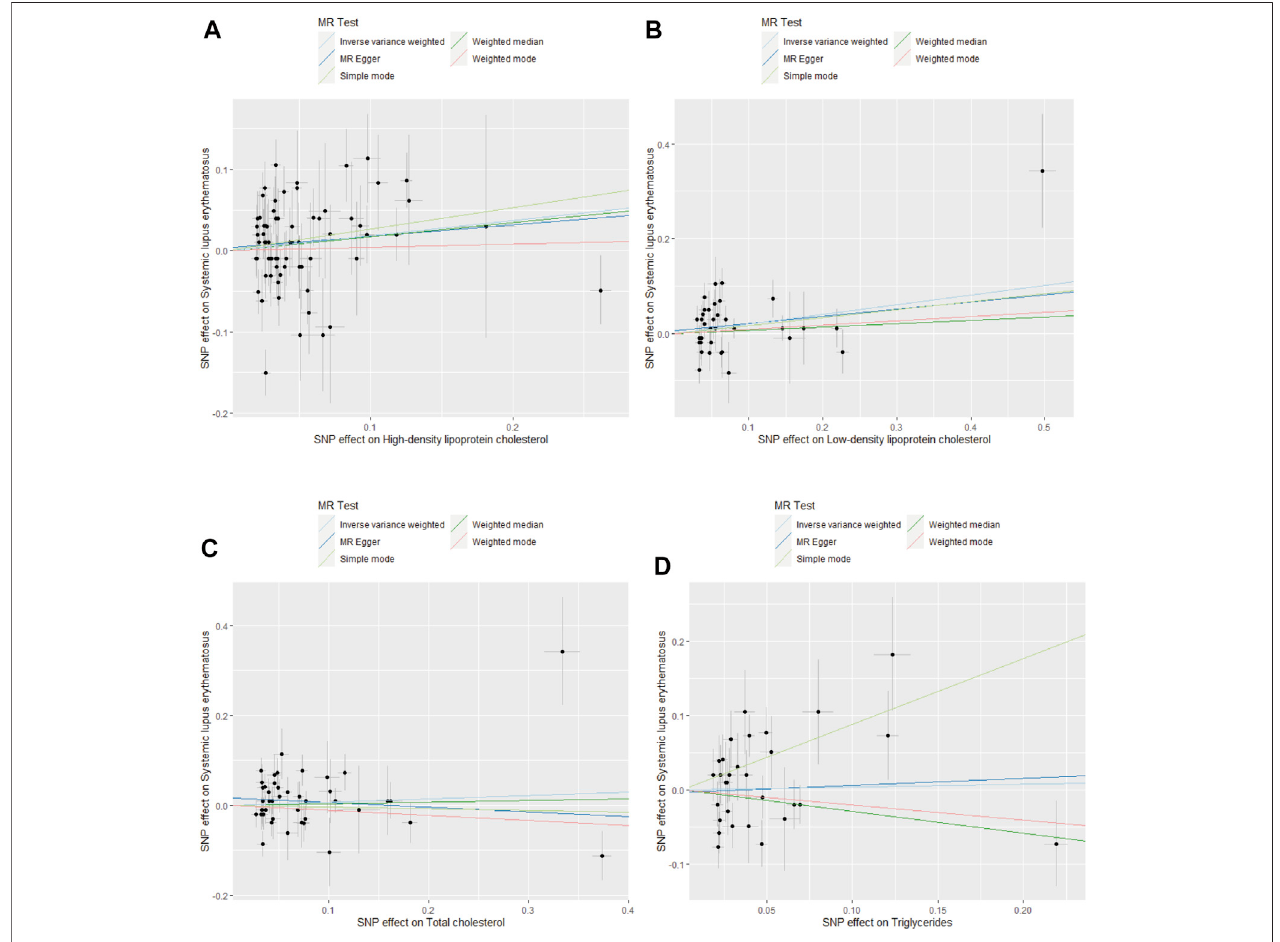
FIGURE 2 | Scatter plots for MR analysis of the causal effect of blood lipids on SLE risk. (A) HDL cholesterol. (B) LDL cholesterol. (C) TC. (D) TG.